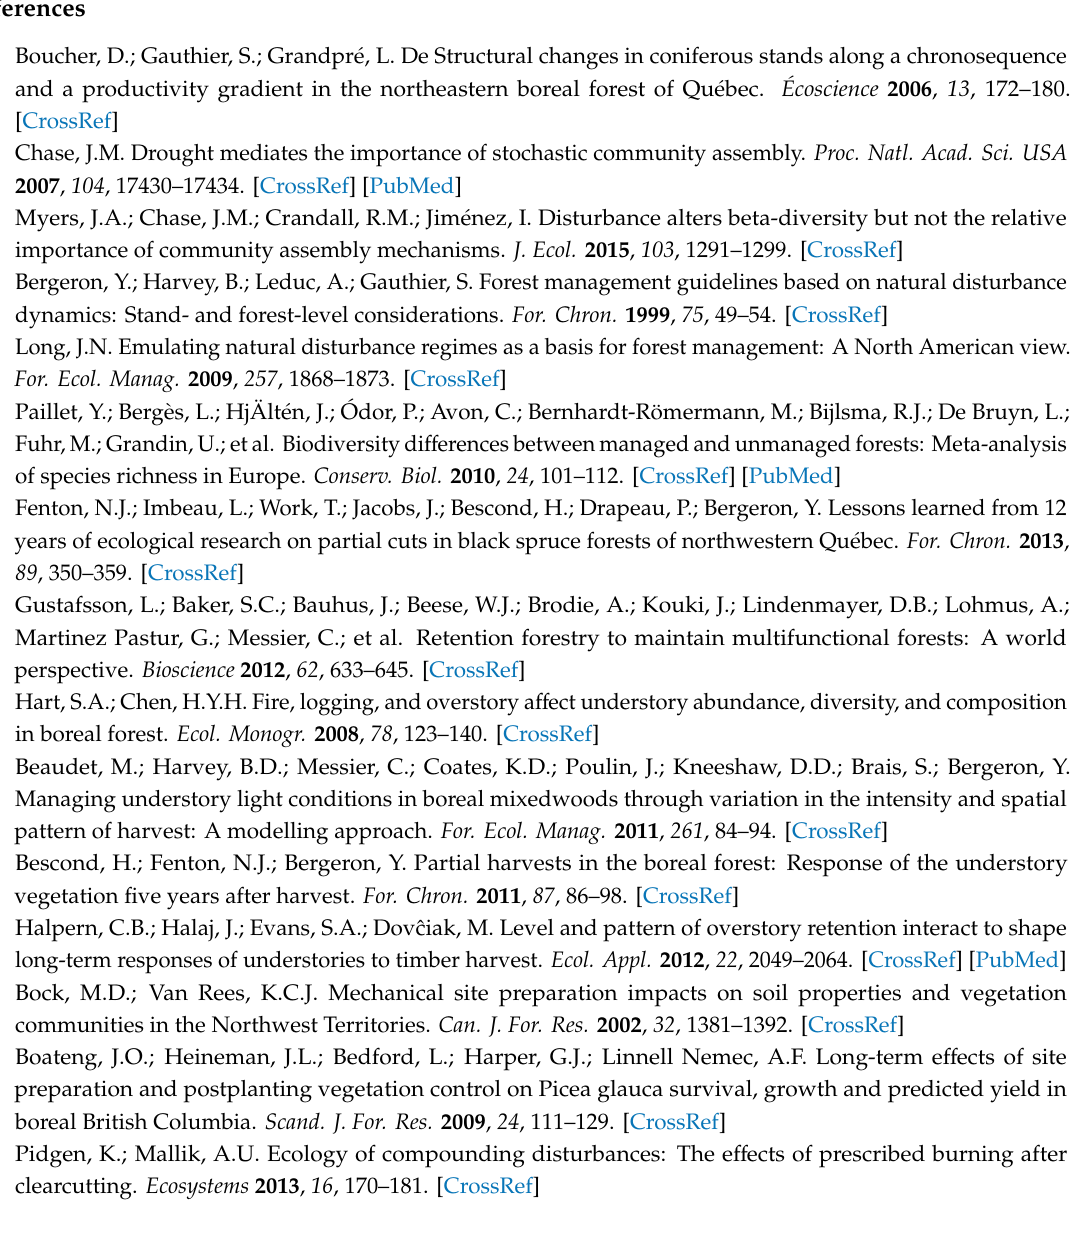
Supplementary Materials: Figure S1. Distribution of functional diversity indices (FRic, FEve, and FDiv) depending on harvesting method (unharvested, CL, and CC). Figure S2. Distribution of the CWM of trait groups depending on harvesting methods (unharvested vs. CL and